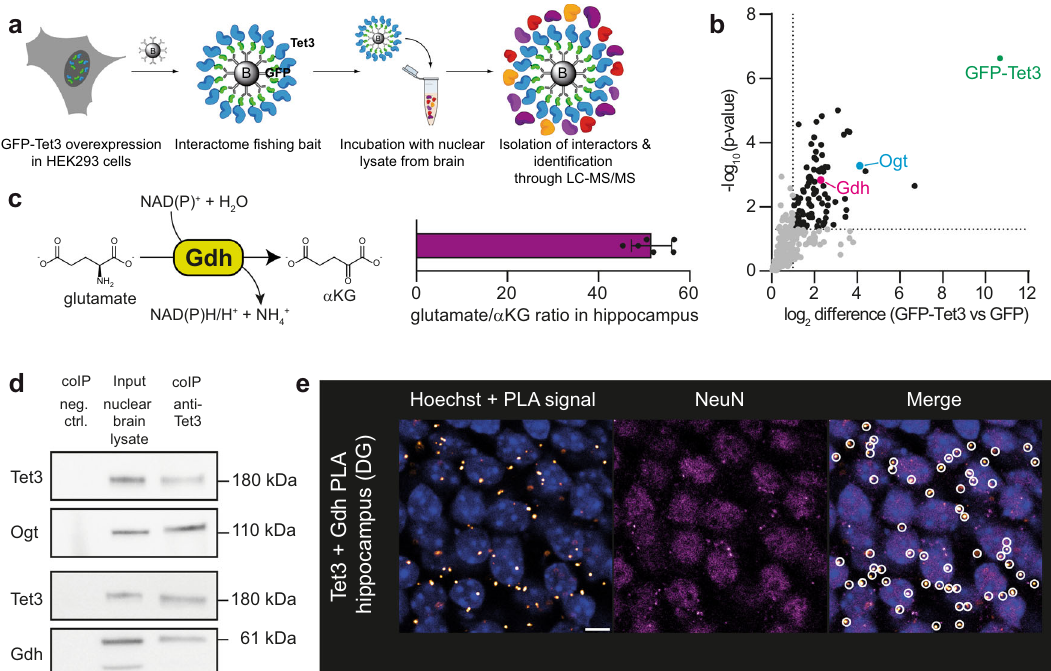
Fig. 2 Interaction of Tet3 with Gdh in neurons. a Experimental set-up for Tet3-enriched coIP. b Volcano plot after Tet3-enriched coIP in nuclear brain lysate of adult mice ( n = 4 biologically independent sample preparations). Interaction partners were analyzed using label-free quanti fi cation after LC – MS/ MS. Enriched interaction partners (FDR < 0.05, log 2 FC > 1) are highlighted in black. c Conversion of glutamate to α KG by Gdh and glutamate to α KG ratio determined by NMR-based metabolomics in murine hippocampus ( n = 6 biologically independent animals, bar shows mean, error bars SD). d Western blots detecting Tet3, Ogt, and Gdh after endogenous Tet3-coIP in nuclear brain lysate. e PLA signal (white/orange dots) of Tet3 and Gdh in the dentate gyrus (DG) of the murine hippocampus. Nuclei (blue) were stained with Hoechst and NeuN staining indicates neuronal nuclei. Scale bar is 5 µ m. Source data are provided as a Source Data fi